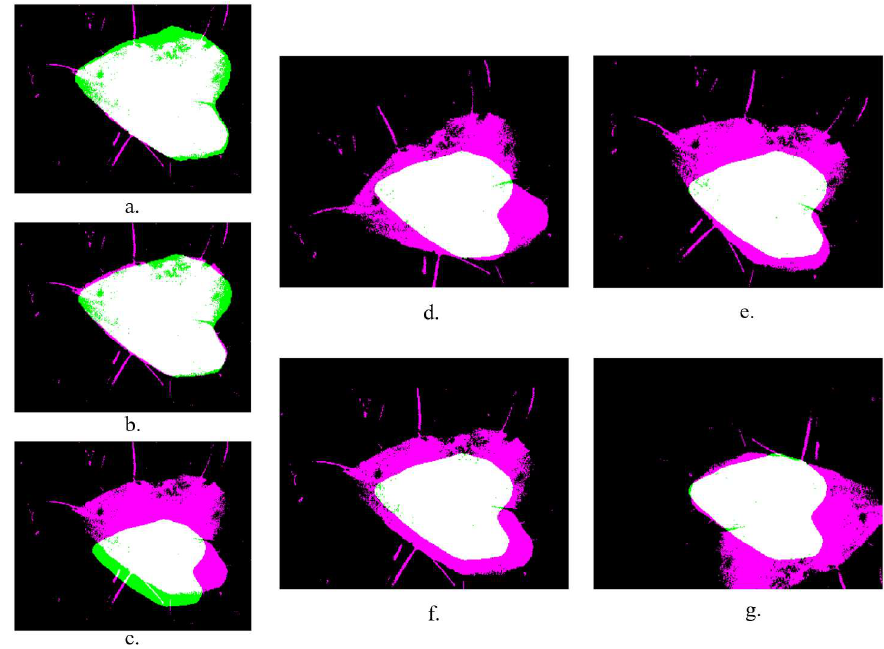
Figure 8. ( a ) SSR, ( b ) Manual, ( c ) initial pair, ( d ) BSO, ( e ) GA, ( f ) Powell, ( g ) PSO.